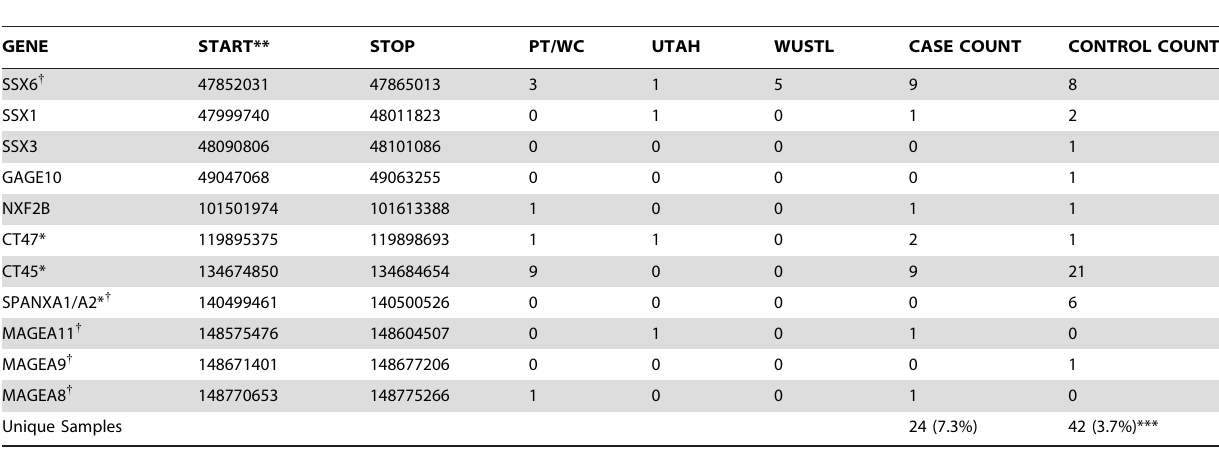
Table 2. X-linked cancer-testis antigens deleted in case and control